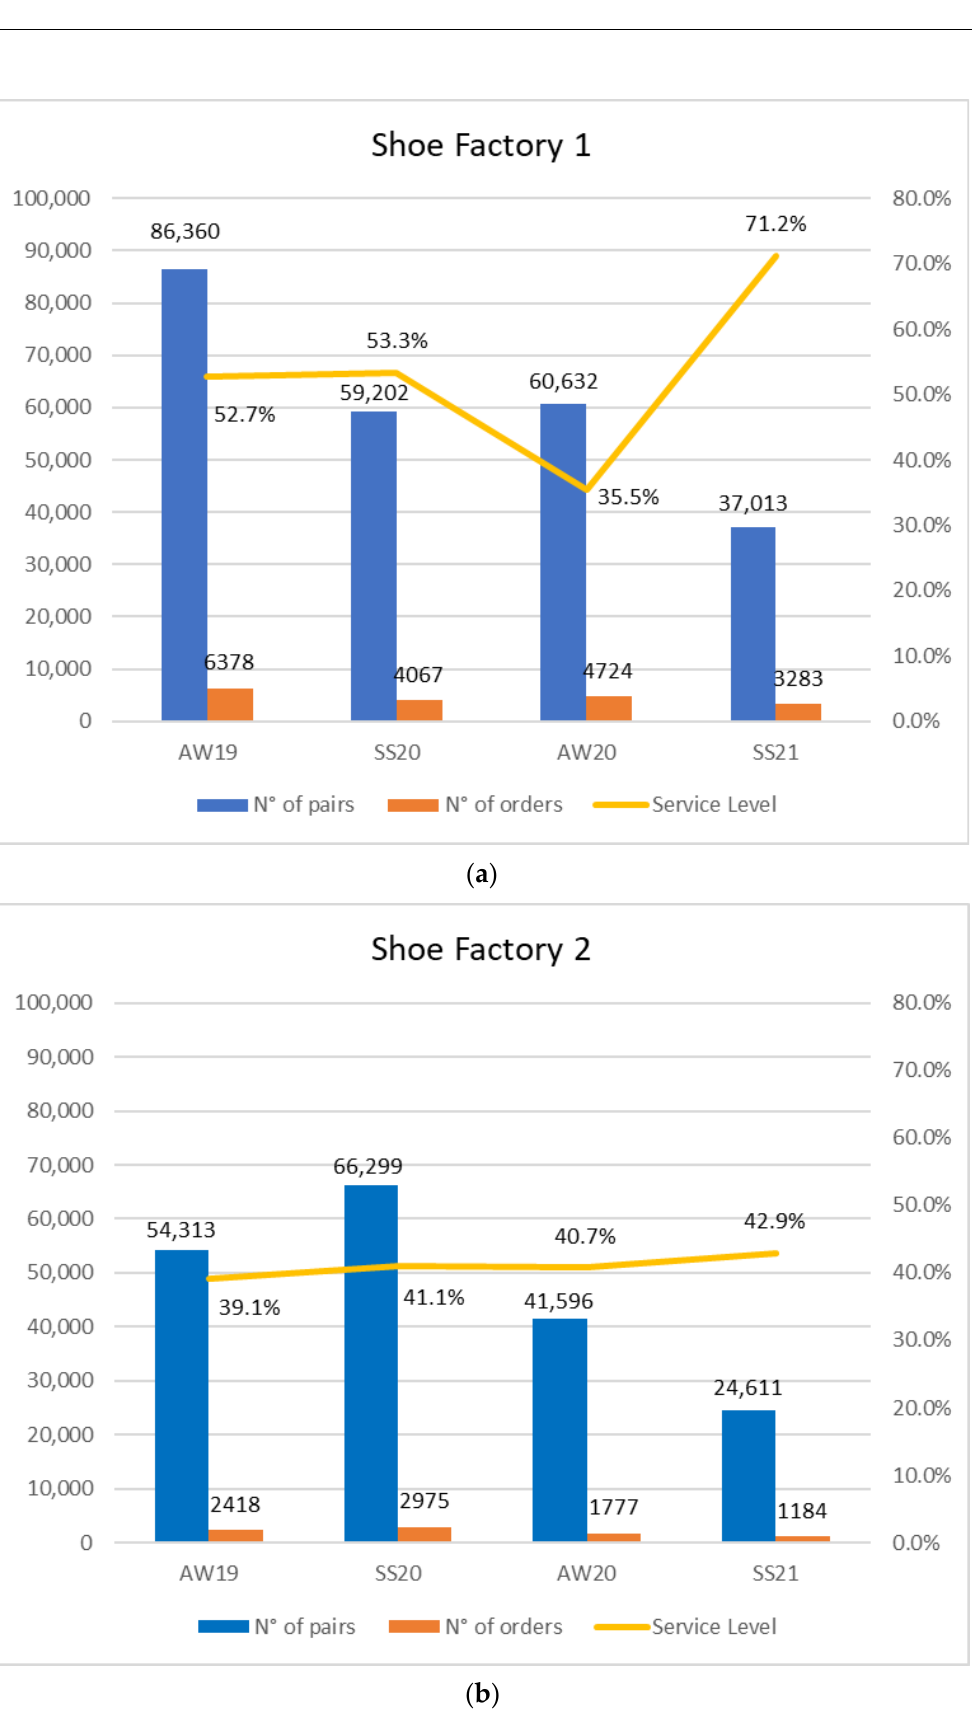
Figure 4. Shoe factory 2 — monthly average production lead time, and N° of orders , considering AW19-SS20 seasons ( a ) and AW20-SS21 seasons ( b ).